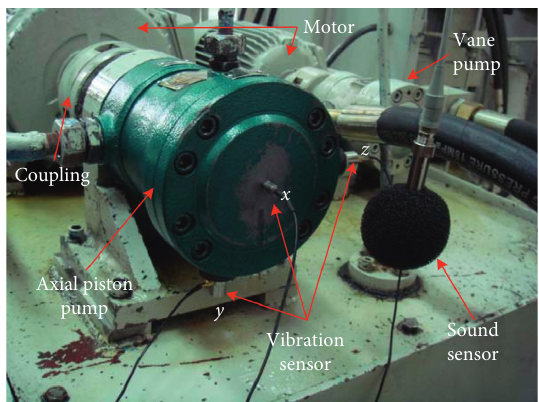
Figure 8: Hydraulic pump failure simulation test